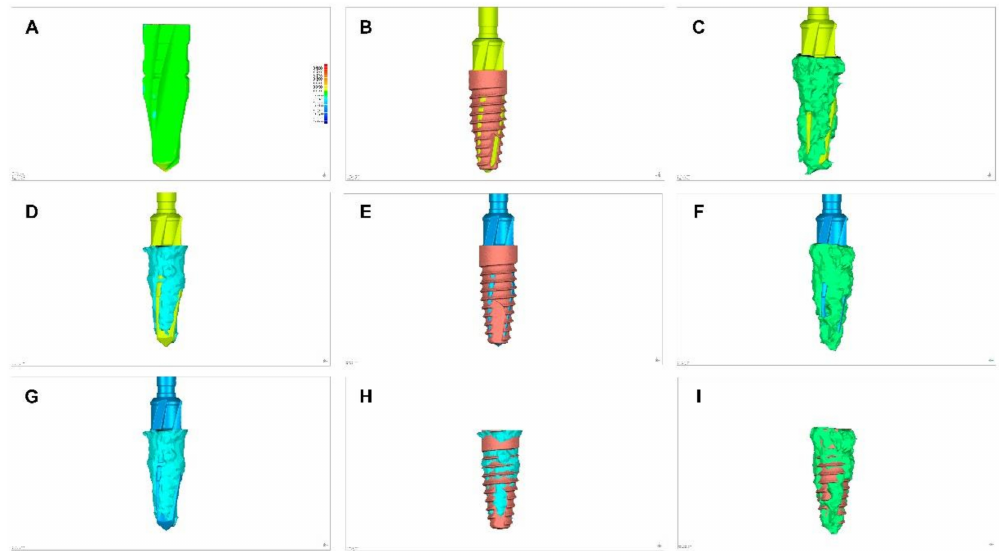
Figure 2. ( A ) Alignments procedures between STL1 and STL2; ( B ) STL1 and STL3; ( C ) STL1 and CBCT 1 ; ( D ) STL1 and CBCT 30 ; ( E ) STL2 and STL3; ( F ) STL2 and CBCT 1 ; ( G ) STL2 and CBCT 30 ; ( H ) STL3 and CBCT 30 ; and ( I ) STL3 and CBCT 1 .